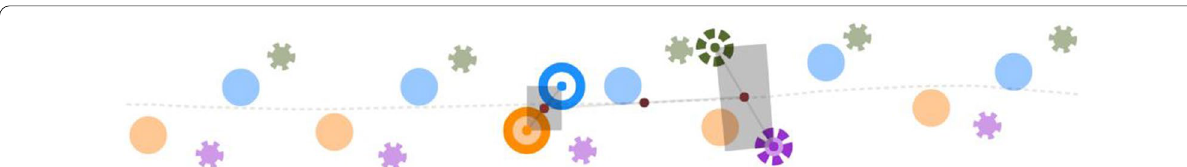
Fig. 5 A diagrammatic representation of a segment of a quadrupedal trackway as it is being traversed by a schematic trackmaker governed by a specific choice of gait parameters for this trial. The track locations are from the BEB-500 S1 trackway; the direction of travel was from left to right (closed shapes indicate the tracks, with pes tracks in blue and orange, and manus tracks in green and mauve). In this trial the gait is a walk ( LP DF 0.5). The trackmaker is indicated by the four locators (with open symbols, a blue ring for left pes, etc.). At the moment depicted, P R , P L , and M R = are in support and standing on tracks, and M L is in transition. Line segments represent the manus and pes couplers, and the line segment CL that connected their midpoints represents the distance between the two couplers. The gray boxes represent the spatial uncertainty of each coupler